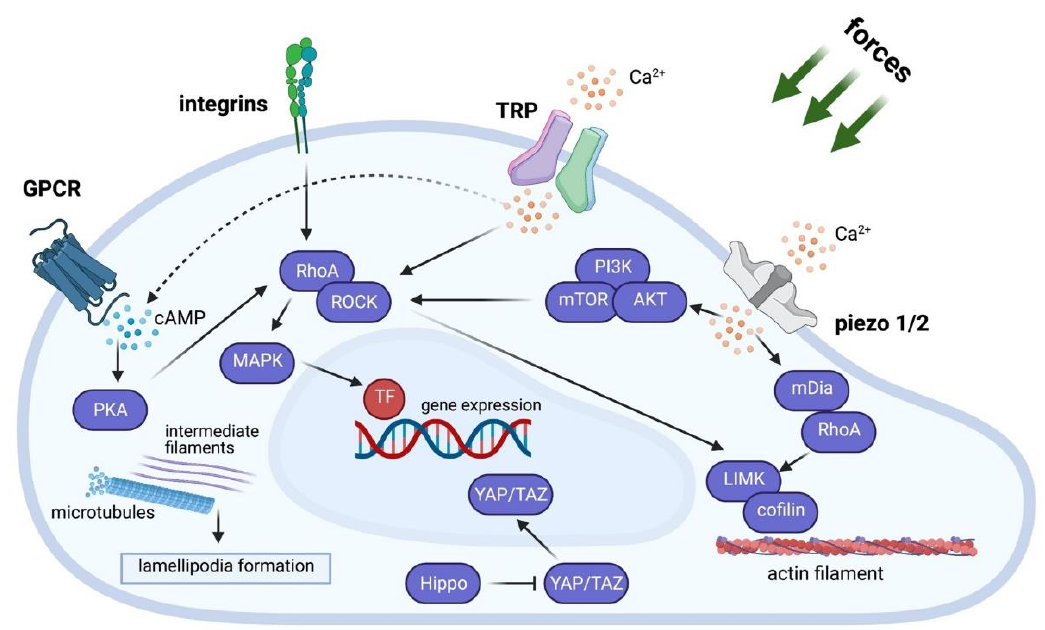
Figure 3. A simplified overview of the mechanotransduction pathways. Illustration depicting the major mechanotransduction pathways that are influenced by force and ultimately affect cell gene expression.